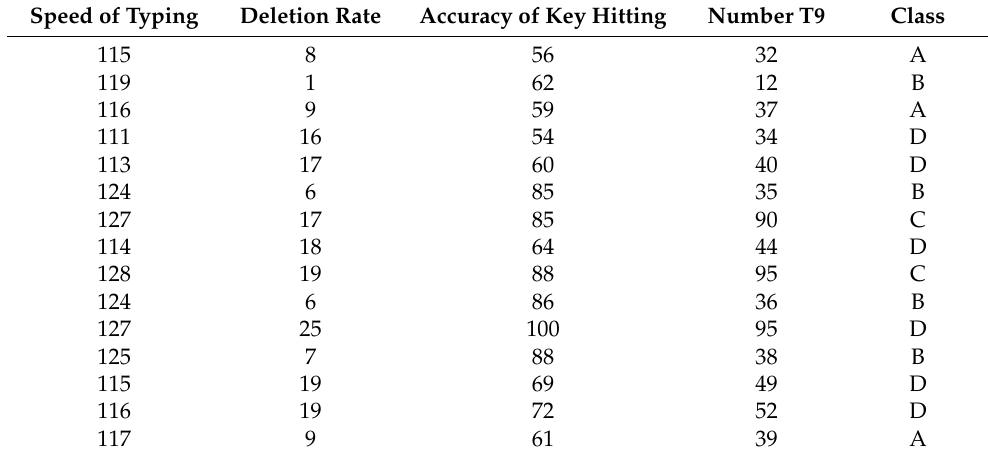
Table 1. Training data of the first set. Speed of Typing